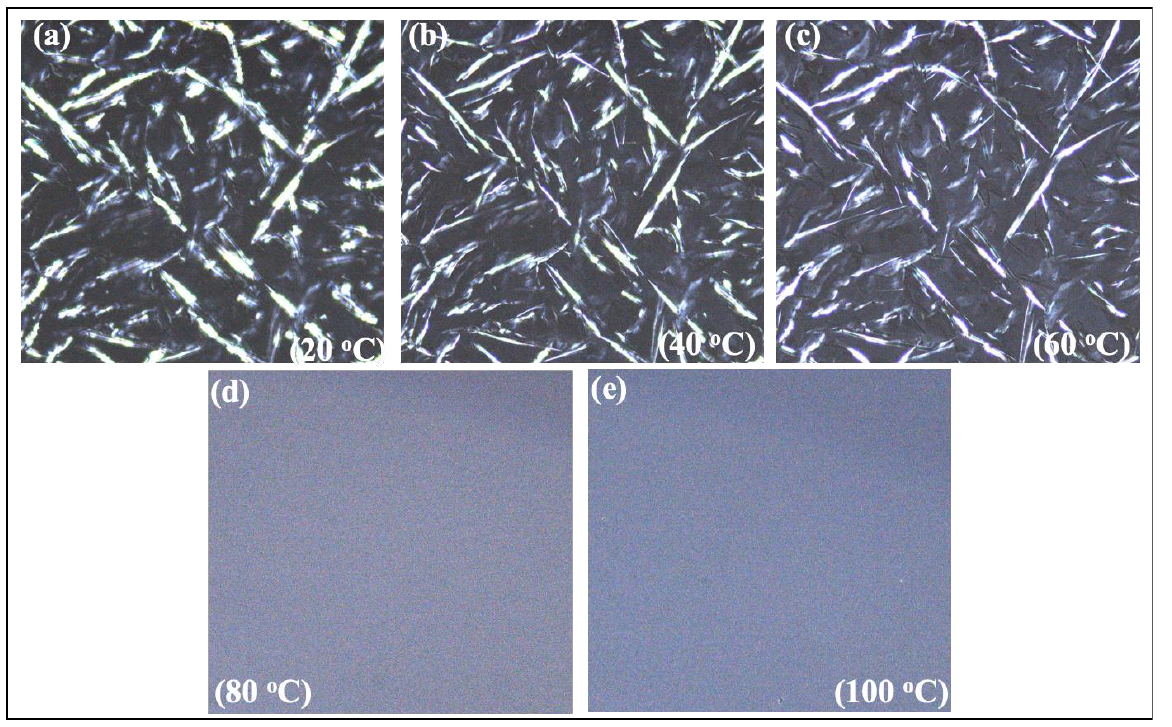
Figure 3. Polarized light microscopy of 3.4% Rice bran wax (RBW) oleogel. ( a ) = wax crystal at 20 ◦ C; ( b ) = wax crystal at 40 ◦ C; ( c ) = wax crystal at 60 ◦ C; ( d ) = wax crystal at 80 ◦ C; ( e ) = wax crystal at 100 ◦ C.